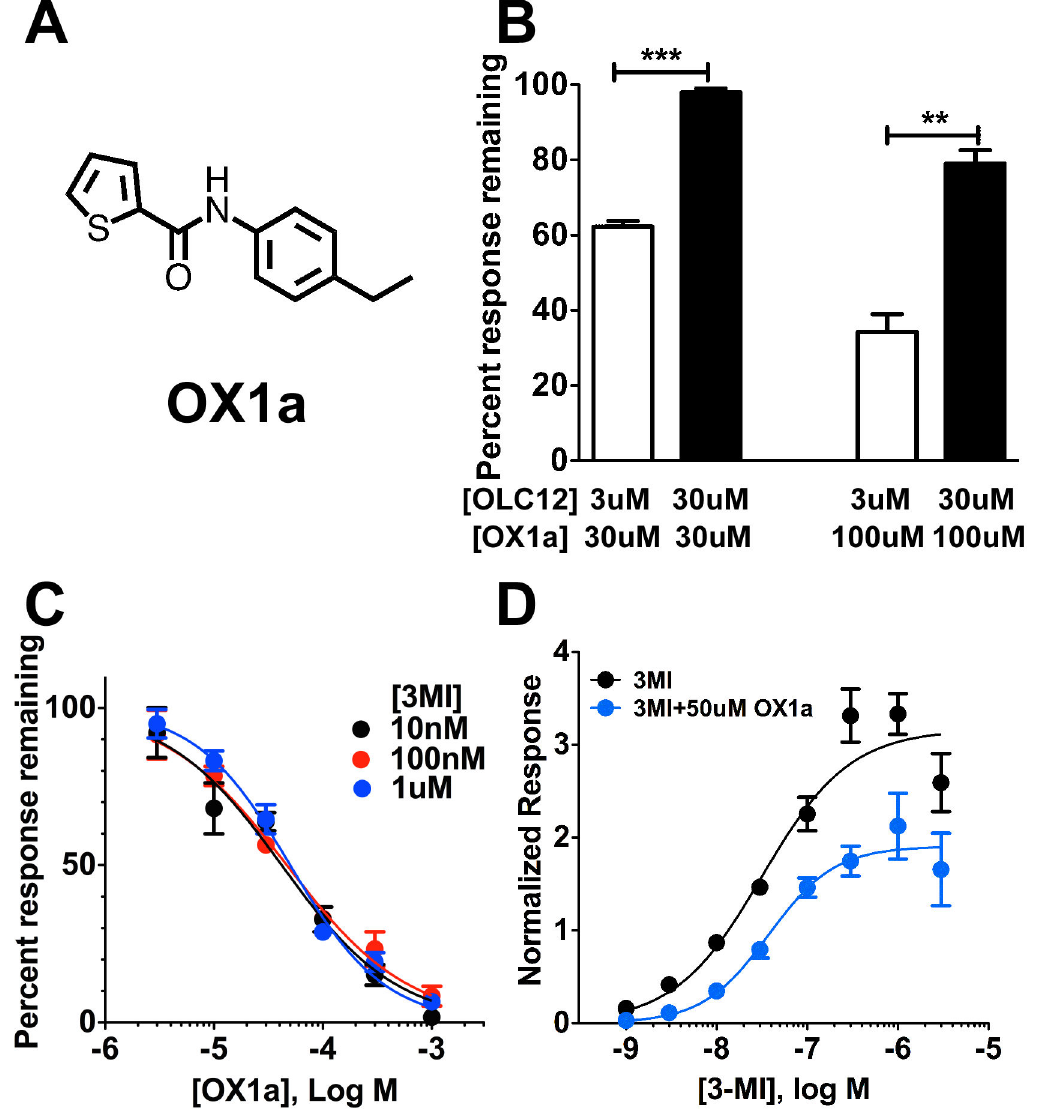
Figure 1. Non-competitive inhibition of odorant activation of an insect OR by an Orco antagonist. A . Structure of N-(4- ethylphenyl)-2-thiophenecarboxamide (OX1a). B . Increasing the concentration of Orco agonist (OLC12) decreases the effectiveness of OX1a. Oocytes expressing Cqui\Orco+Cqui\Or21 were activated with 3 µM or 30 µM OLC12, in the absence or presence of 30 µM or 100 µM OX1a. Responses in the presence of OX1a are presented as a percentage of the average of the two preceding responses to OLC12 alone (mean ± SEM, n=3). Statistical significance: **p<0.01, ***p<0.001 (two-tailed, unpaired t-test). C . OX1a inhibition of Cqui\Orco+Cqui\Or21 activation by 3-methylindole (3MI) is not altered by changes in odorant (3MI) concentration. IC values for OX1a inhibition of responses to 10nM 3MI (47 ± 5 µM), 100nM 3MI (42 ± 7 µM) and 1uM 3MI (50 ± 4 50 µM) did not differ (p=0.2970, F-test). D . Co-application of 50 µM OX1a significantly reduces the maximal response to 3MI, as compared to the response to 3MI in the absence of OX1a (p<0.0001, F-test). The EC for 3MI activation of Cqui\Orco+Cqui\Or21 in 50 presence of 50 µM OX1a (37 ± 7 nM) did not differ (p=0.57, F-test) from the EC for activation of Cqui\Orco+Cqui\Or21 by 3MI 50 alone (32 ± 7 nM). doi: 10.1371/journal.pone.0084575.g001 \Or21 ranging from 1.7 µM to 14 µM (Table 1), all a significant methyl decorations at the 2 and 3 positions of the phenyl ring; improvement over OX1a (IC = 51 ± 6 µM). Two of the four OX1l, with methyl decorations at the 2, 4 and 6 positions of the 50 most potent compounds were from the OX1 series: OX1k, with phenyl ring. The other two compounds were OX3a, with a